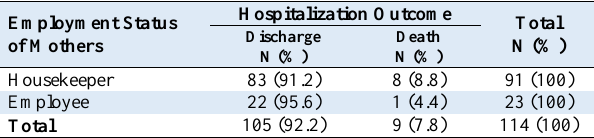
Table 2. The relationship between mortality of premature infants among mothers and premature infant mortality Mortality of Premature Infants among Mothers